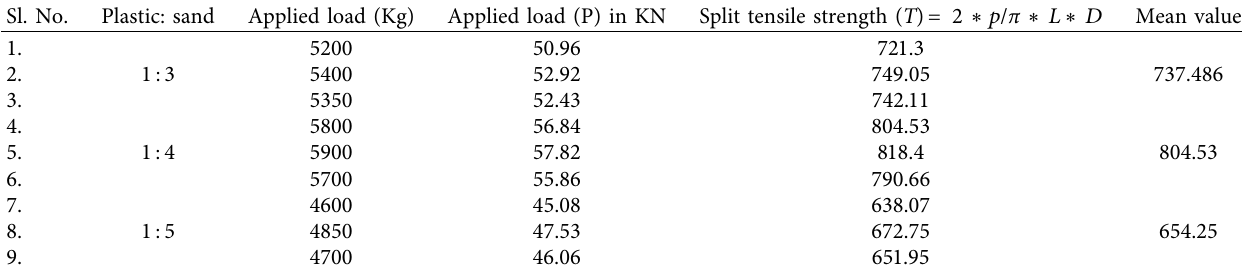
Table 9: Split tensile strength test results of plastic sand bricks.